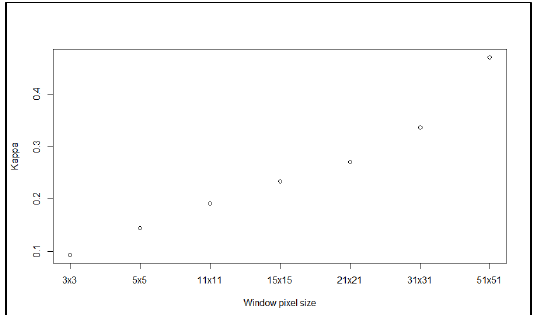
Figure 2. Comparison of classification accuracy based on texture windows sizes.